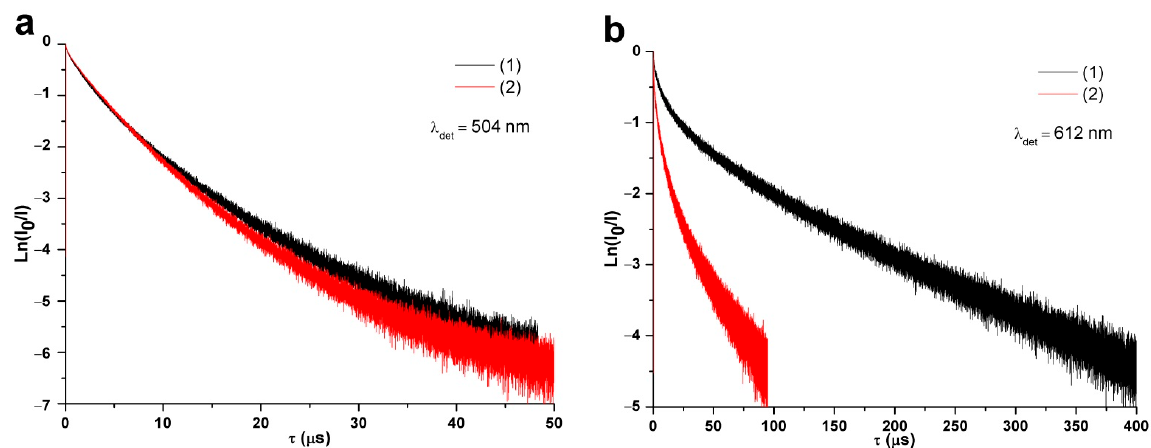
Figure 8. Extinction kinetic curves of luminescence from the 3 P 0 and 1 D 2 levels of the Pr 3+ ions in (1) (ZrO 2 ) 0.802 (Y 2 O 3 ) 0.195 (Pr 2 O 3 ) 0.003 and (2) (ZrO 2 ) 0.805 (Y 2 O 3 ) 0.188 (Pr 2 O 3 ) 0.007 crystals, λ exc. = 450 nm, ( a ) λ det. = 504 nm, ( b ) λ det. = 612 nm.